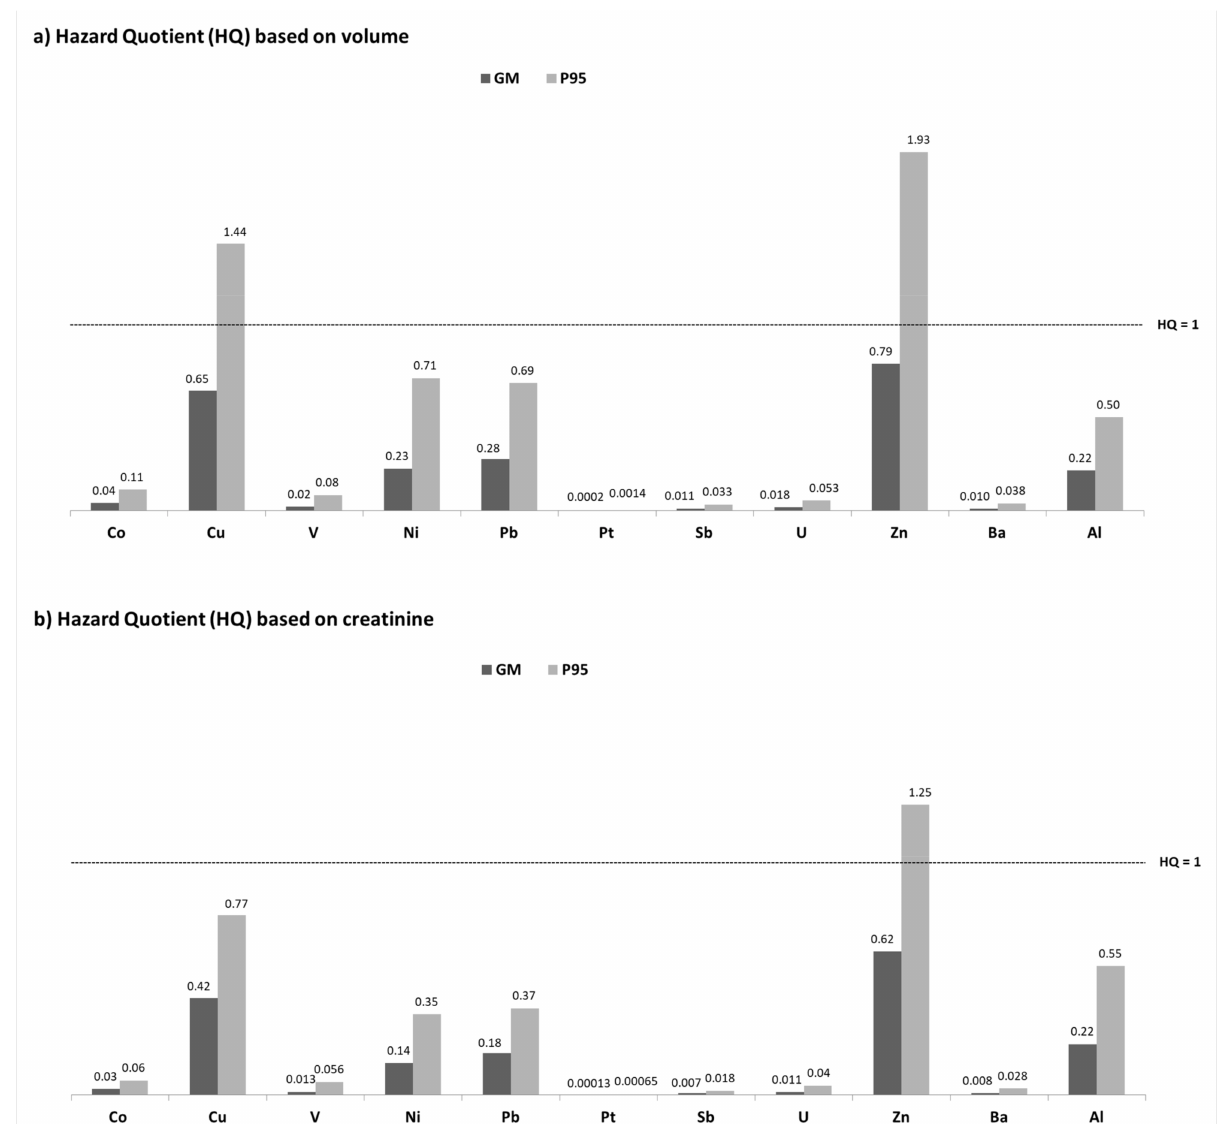
Figure 2. Hazard quotients for some metal concentrations based on volume ( a ) and creatinine ( b ). GM: geometric mean; P95: 95th